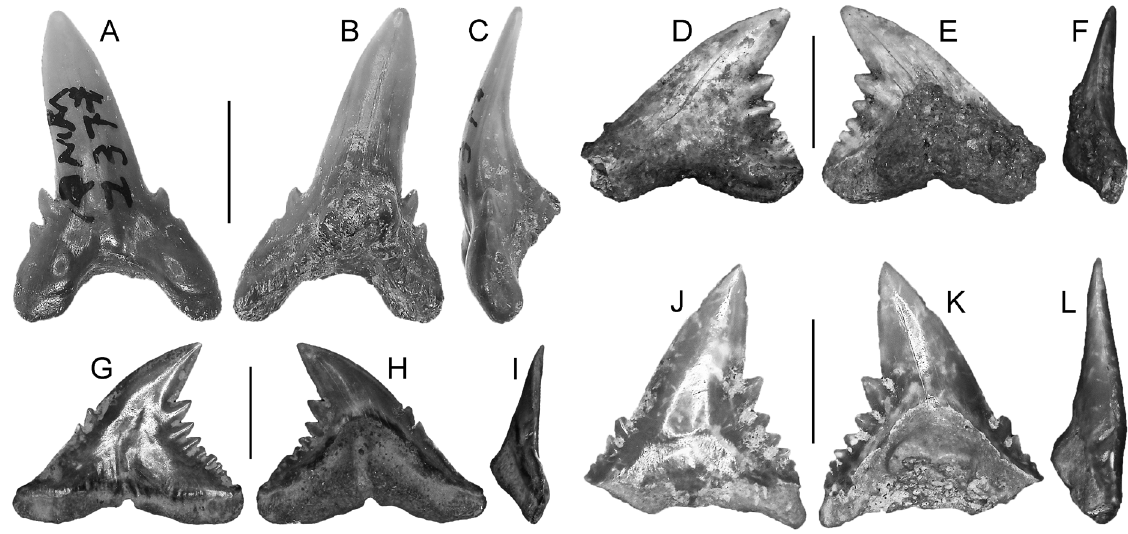
Fig. 24. Hemipristis curvatus Dames, 1883, teeth. A–C . MSC 2377, lower anterior tooth, Gosport tooth, Gosport Sand. D . Labial view. E . Lingual view. F . Mesial view. G–I . ALMNH PV1994.4.221, upper lateral tooth, Gosport Sand. G . Labial view. H . Lingual view. I . Mesial view. J–L . ALMNH PV1994.4.189, lower lateral tooth, Gosport Sand. J . Labial view. K . Lingual view. L . Mesial view. Scale bars = 5